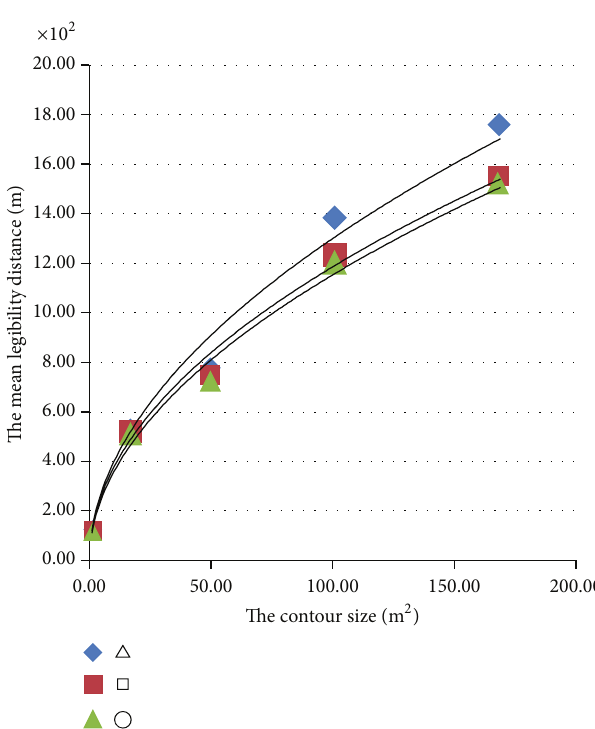
Figure 5: Relationship between the mean legibility distance and the contour size under 80 km/h, where the relationship between the mean legibility distance and the contour size under 80 km/h was for triangle: 𝑦 = 121.1𝑥 0.515 and 𝑅 2 = 0.892 , and for round: 𝑦 = 110.2𝑥 0.509 and 𝑅 2 = 0.902 .